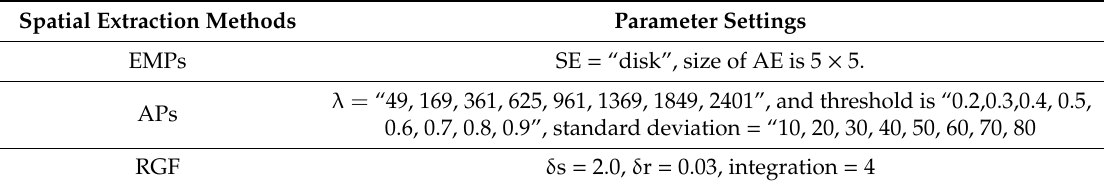
Table 2. Parameter settings for spatial feature extraction